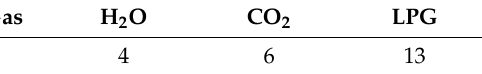
Table 4. Yield factors for the upgrading of bio-oil (data adapted from [2]).